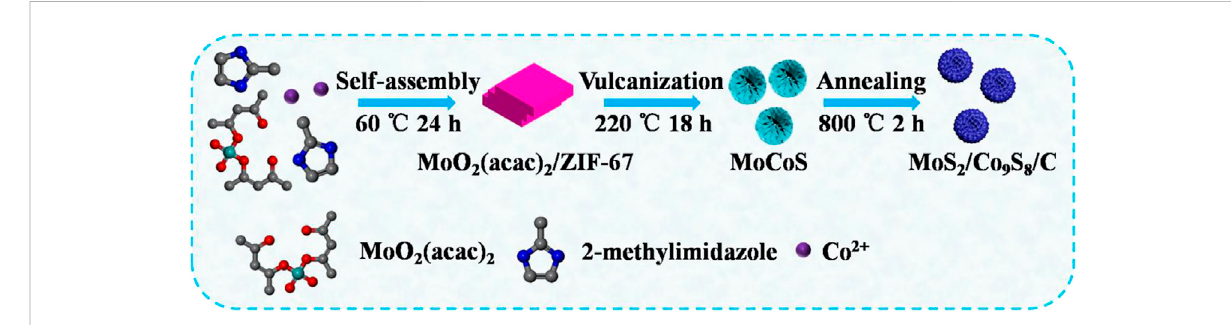
FIGURE 1 Schematic illustration of the formation process of the petal-like MoS 2 /Co 9 S 8 /C nanohybrids.